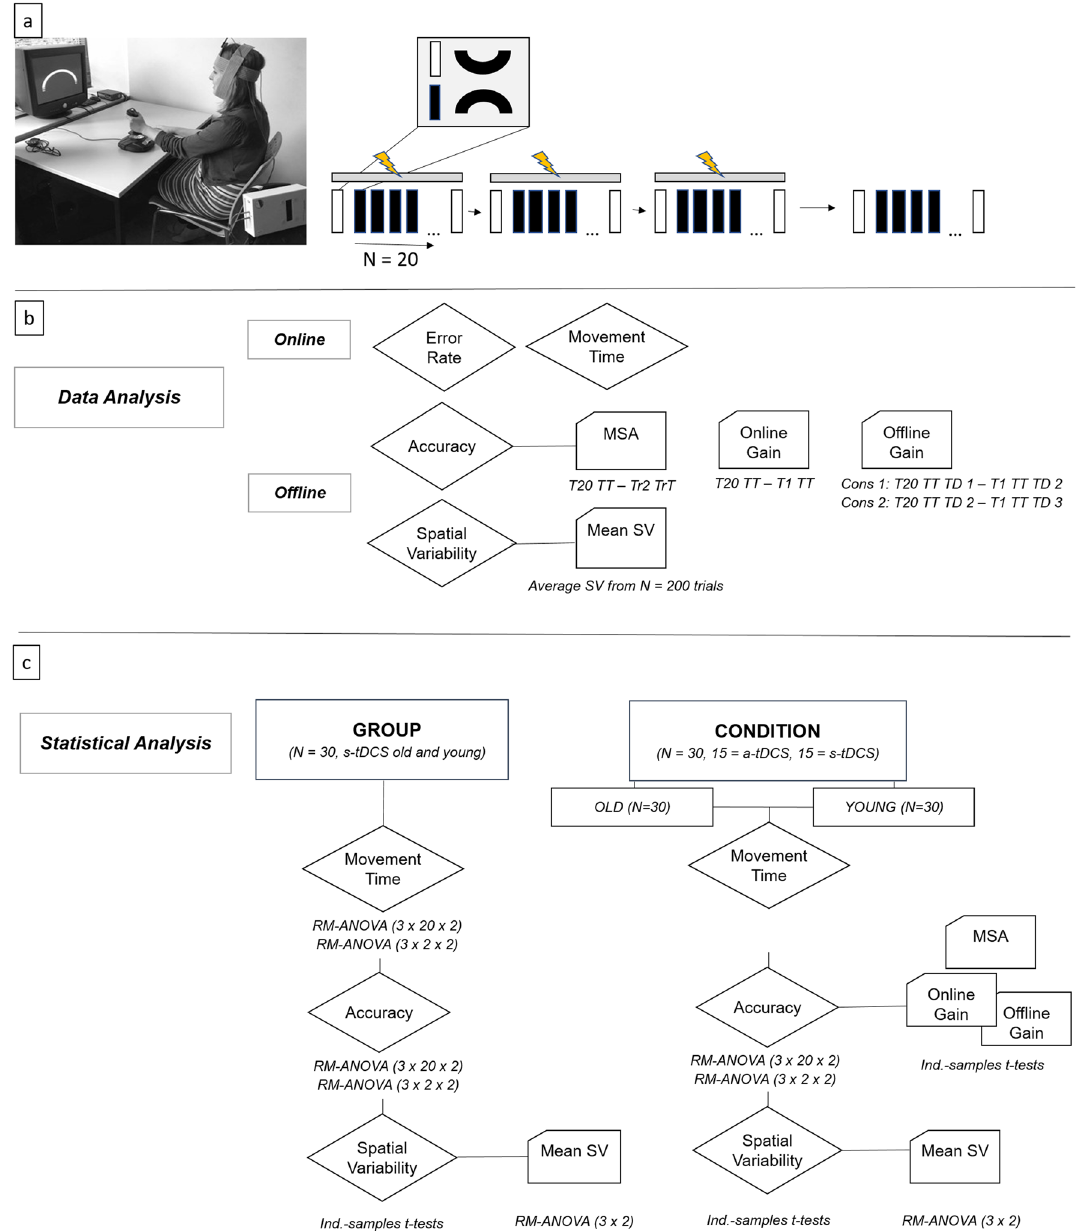
Figure 1. ( a ) Study design. Participants sat facing a computer screen with their left wrist on a joystick while they received 20 min of a-tDCS or s-tDCS over the contralateral primary motor cortex. Their main task was to move the cursor from the start to the target box through the arc channel without exceeding the channels boundaries as fast and as accurately as possible. The study consisted of three consecutive training days with tDCS (indicated by yellow flash) seperated by 24 h and a retention day without tDCS 1 week later. Each training day consisted of 20 learning (black rectangle) and 2 transfer trials (white rectangle). Learning trials included upward movements in clockwise direction, transfer trials downward movements in counter-clockwise direction. ( b ) Data analysis. MSA: movement specific accuracy, TT: training trial, TrT: transfer trial, TD1: training day 1, TD2: training day 2, TD3: training day 3, SV: Spatial Variability. Online calculations included movement time and error rate calculation. Offline calculations included accuracy calculation (1-error rate) and calculation of SV (variability of time-normalized radial position data). Furthermore, subparameters of accuracy were calculated: MSA corresponds to the absolute difference between last TT (T20) and second TrT (Tr2). Online gain scores were calculated as difference between T20 TT and T1 TT. Offline gain scores were calculated as differences between last and first TT of consecutive TDs, values > 0 represent skill consolidation and values < 0 represent skill loss. ( c ) Statistical analysis. RM-ANOVA: repeated-measures analysis of variances, ind-samples t-tests: independent samples